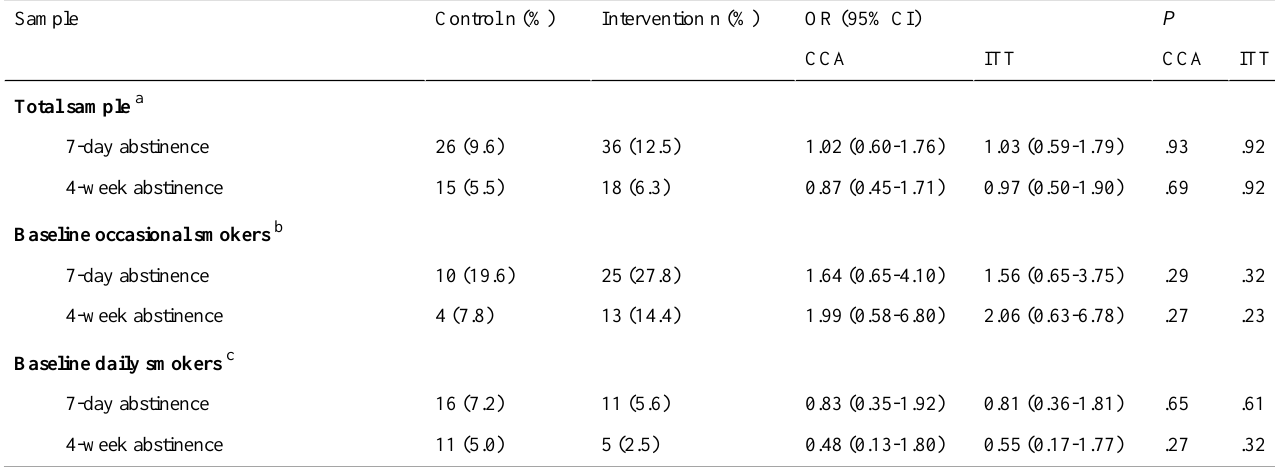
Table 2. Point prevalence smoking abstinence rates at follow-up (complete-case data) and results of logistic regression analyses comparing abstinence rates in the study groups using complete-case analyses (CCA) and intention-to-treat analyses (ITT).